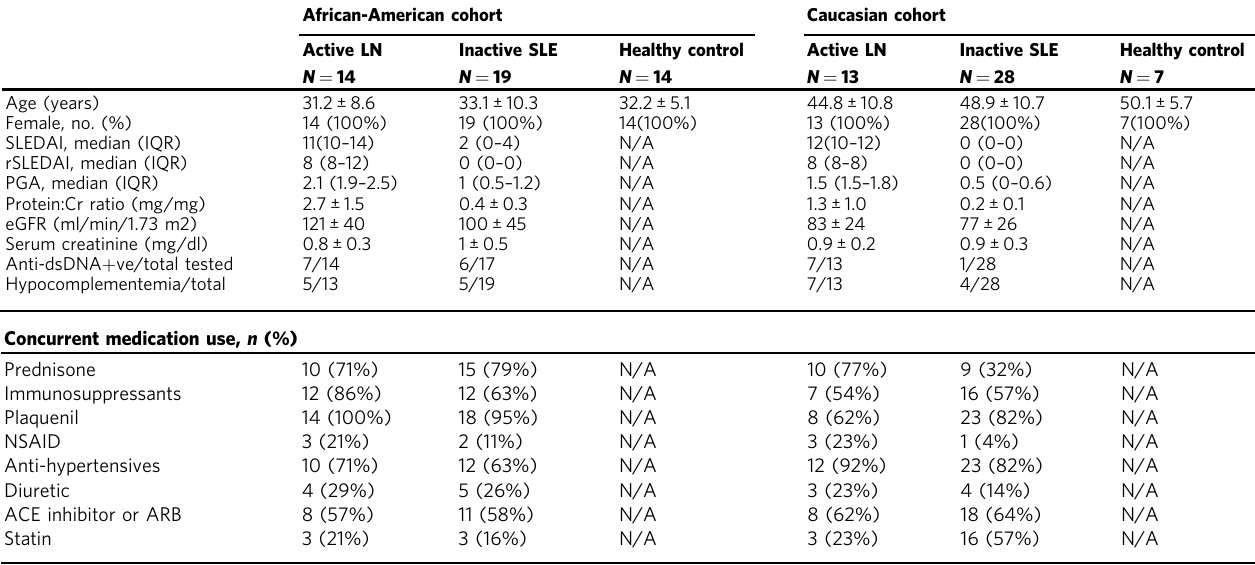
Table 2 Patient cohort used for the cross-sectional validation studies.